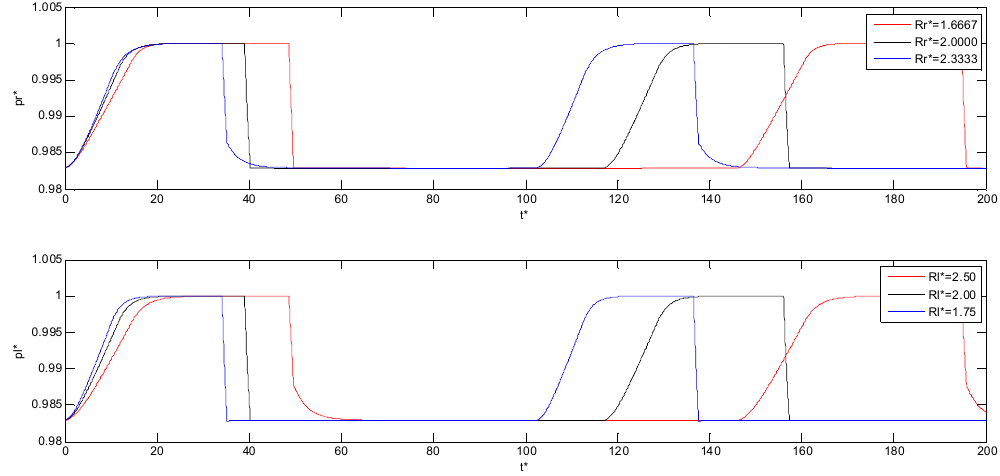
Figure 11. Influence of dimensionless air resistance on dimensionless pressure of two lungs.